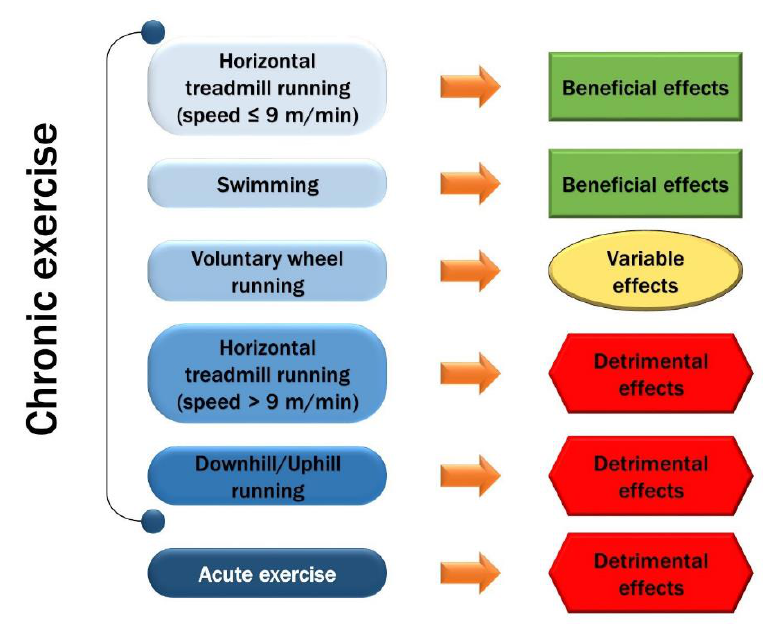
Figure 3. Graphical Abstract. From Frinchi, M. et al. [9].